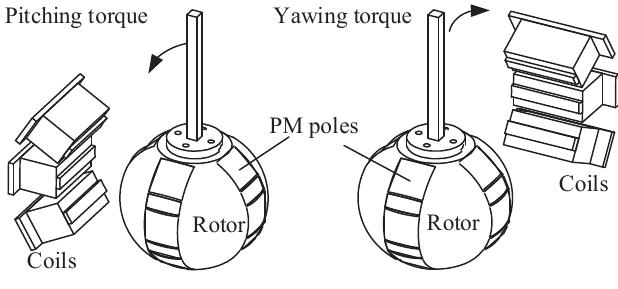
Figure 2. Operating principle of spherical actuator.